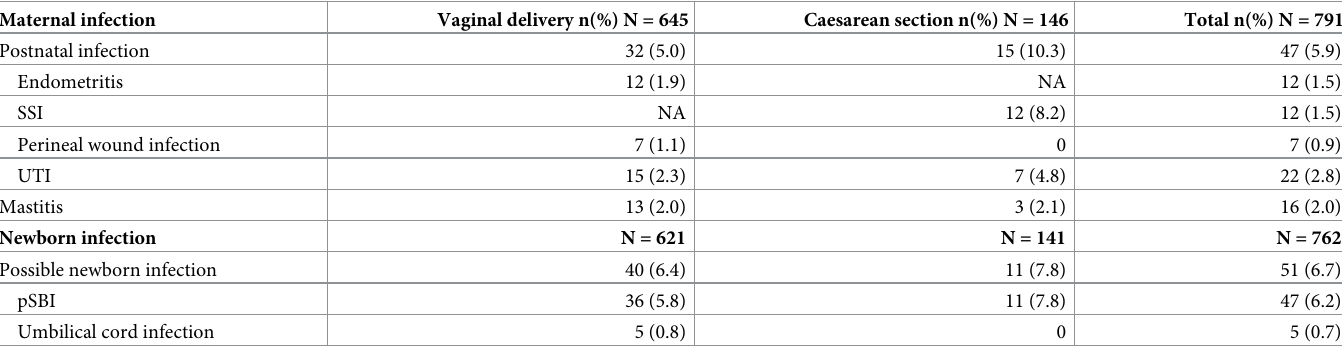
Table 4. Maternal and newborn infections occurring up to 7 days after